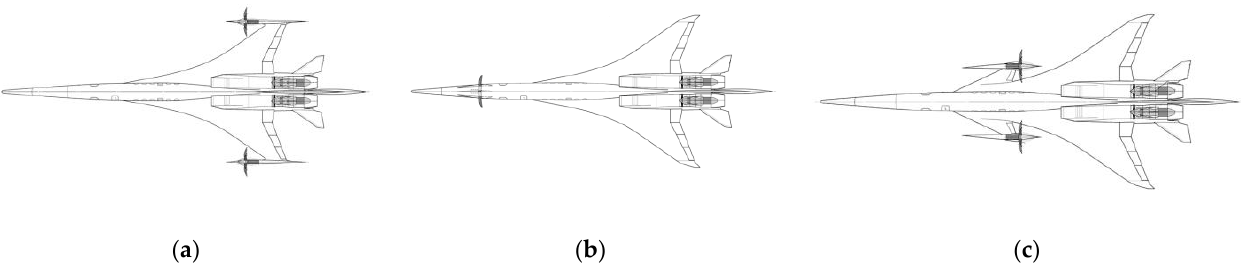
Figure 6. Different variants of supersonic aircraft with buster turboprop engines: ( a ) propellers in tractor configuration; ( b ) a propeller at the aircraft nose; ( c ) propellers at forward winglets.